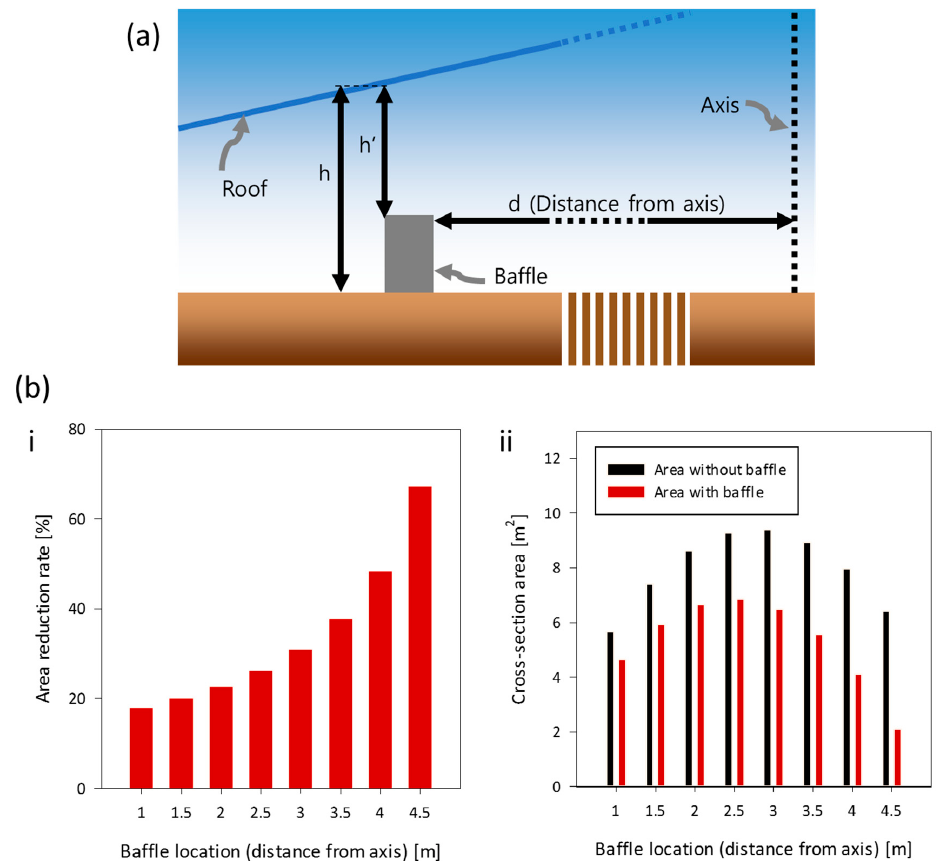
Figure 8. The cross-sectional areas of flow path changes according to baffle position: ( a ) Reductions of the cross section on the baffle distance are calculated based on the geometric parameters. ( b ) The quantitative value of a cross-sectional reduction on the baffle distance: (i) the cross-sectional area reduction rate and (ii) a cross-sectional area comparison with and without a baffle. Energies 2019 , 12 , x FOR PEER REVIEW